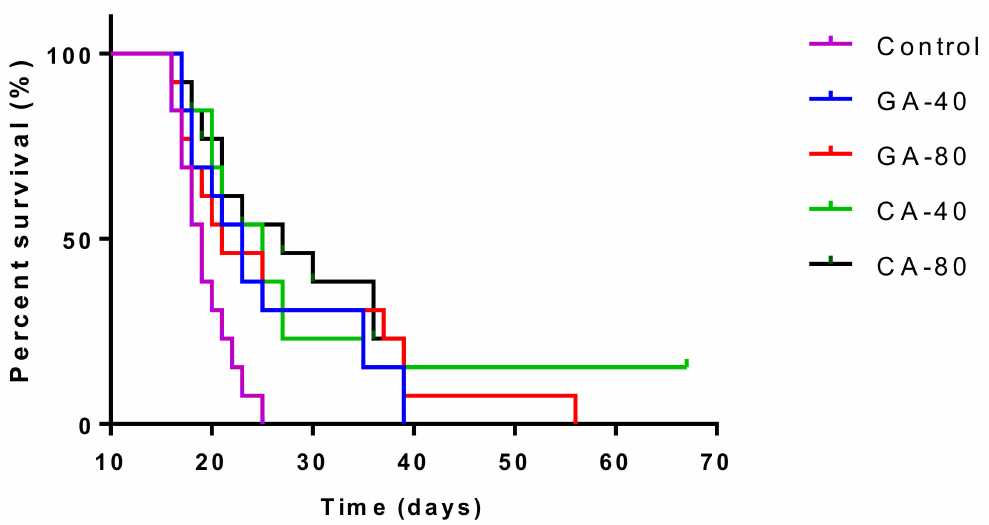
Figure 1. Kaplan–Meier survival curves of mice bearing EAT after treatment with GA and CA. Mice were injected intraperitoneally ( ip ) with 2.5 × 10 6 viable EAT cells and treated with GA or CA at a dose of 40 and 80 mg / kg ip in exponential tumor × growth phase on days 5, 7, 9, and 11. The results are expressed as the mean value of each experimental group ± SE of the mean ( n = 11). Abbreviations: EAT, Ehrlich ascites tumor; GA, gallic acid; CA, ca ff eic